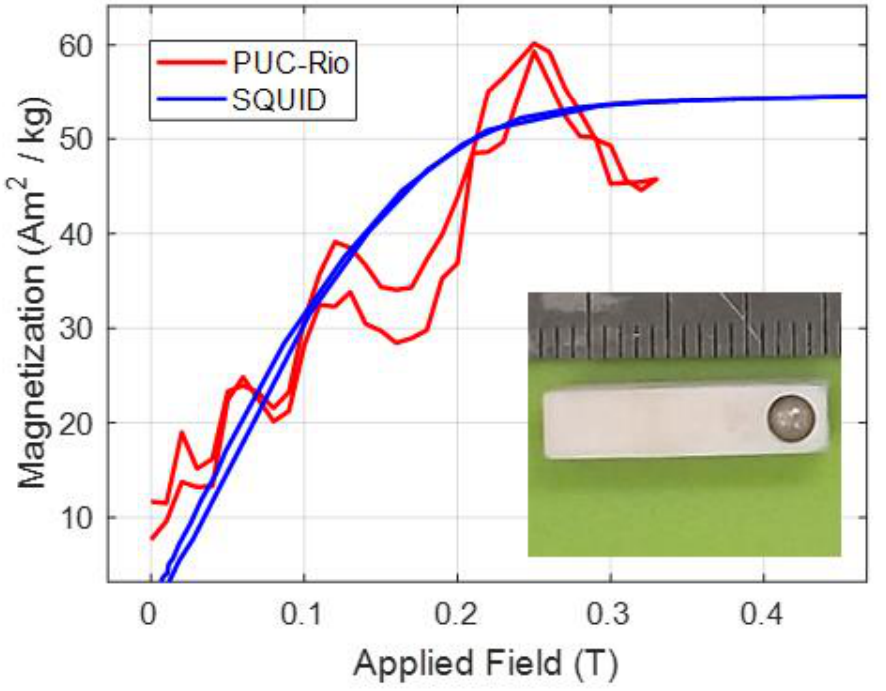
Figure 5. ( a ) Continuous curve in the red color of a 99% pure nickel sphere, obtained by a magnetometer built at PUC-Rio. ( b ) Continuous curve in the blue color of a 99% pure nickel sphere, obtained by a commercial magnetometer (MPMS SQUID, Quantum Design Inc.). In the inset of the figure, the sample holder with a 99% pure nickel sphere is highlighted.